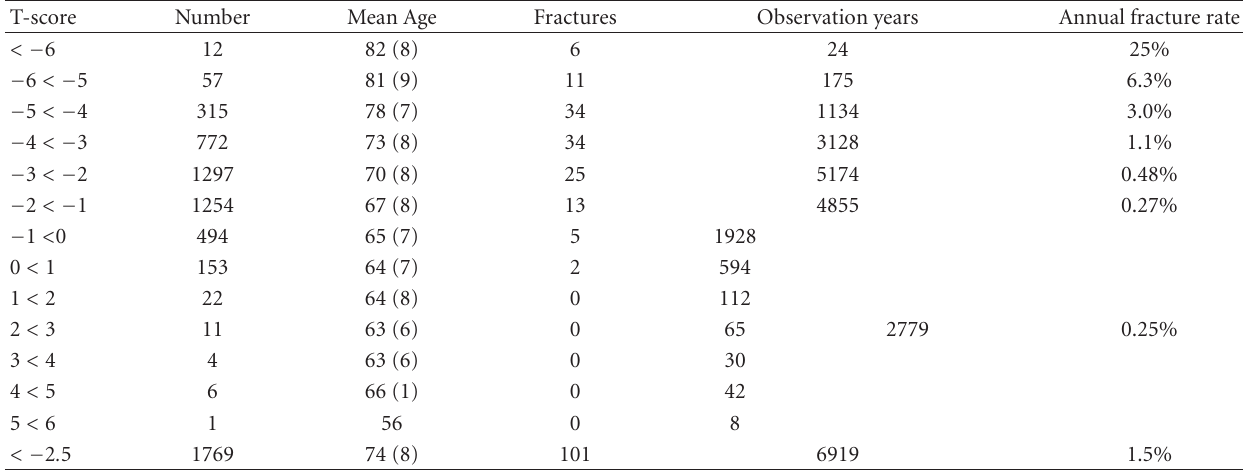
Table 2: The number of individuals with di ff erent T-scores, their mean age with 1 standard deviation within parenthesis, the number of fractures, observation years and the annual fracture